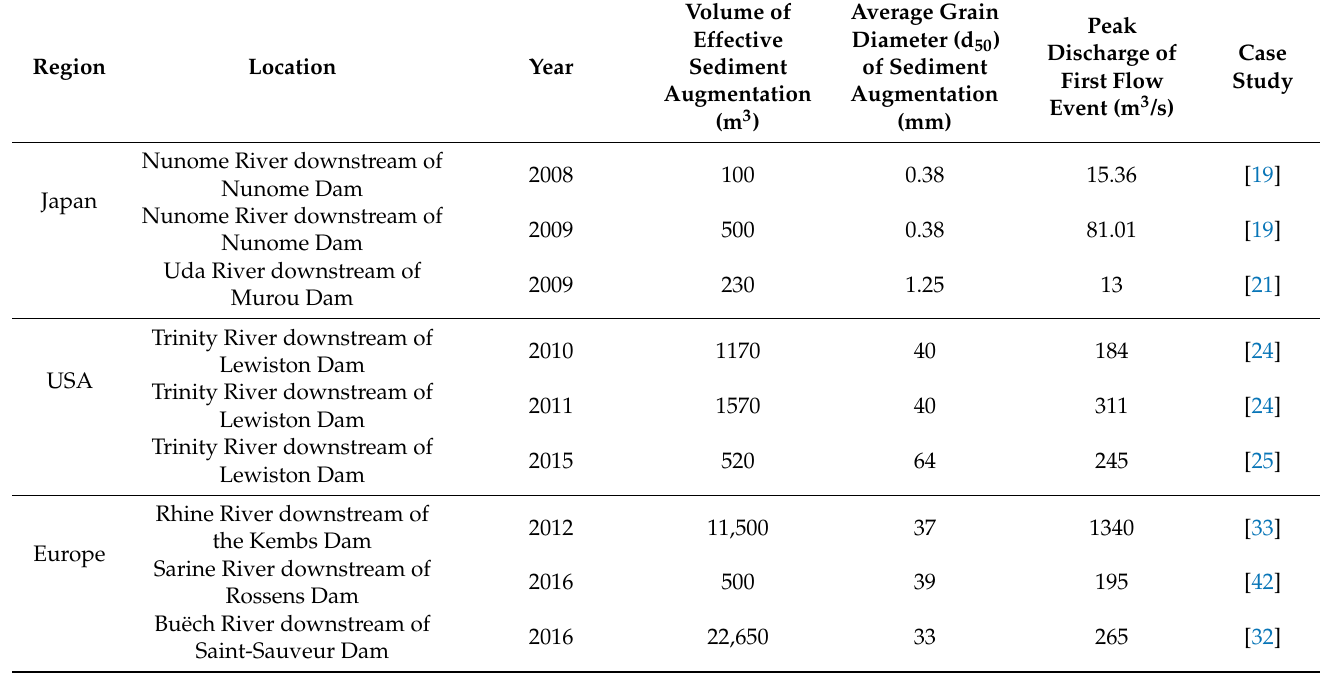
Table A1. Data and source of scatter plot Figure